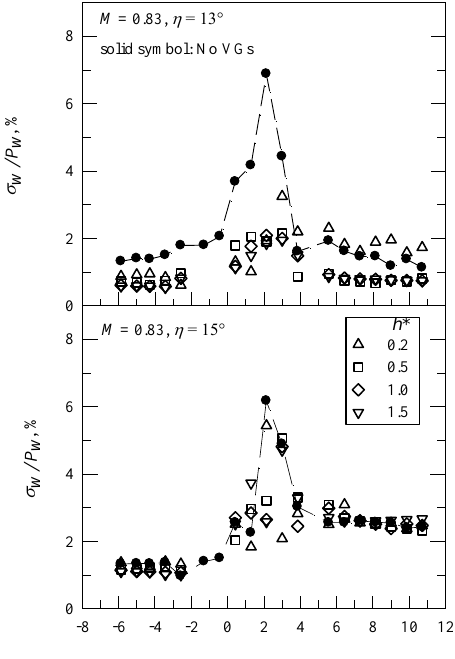
Figure 7. Distribution of surface pressure fluctuations for M = 0.83.